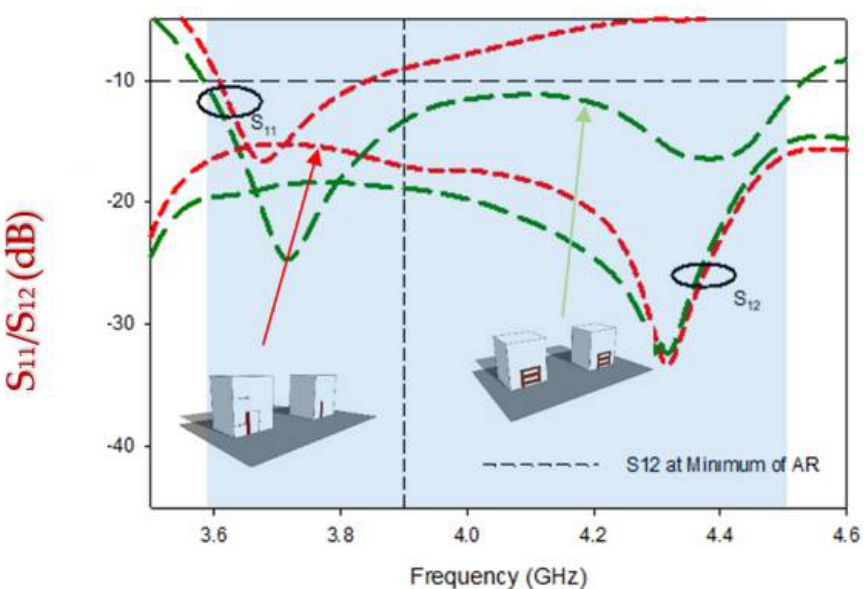
Figure 10. Comparison of mutual coupling in Design-1 and Design-2.